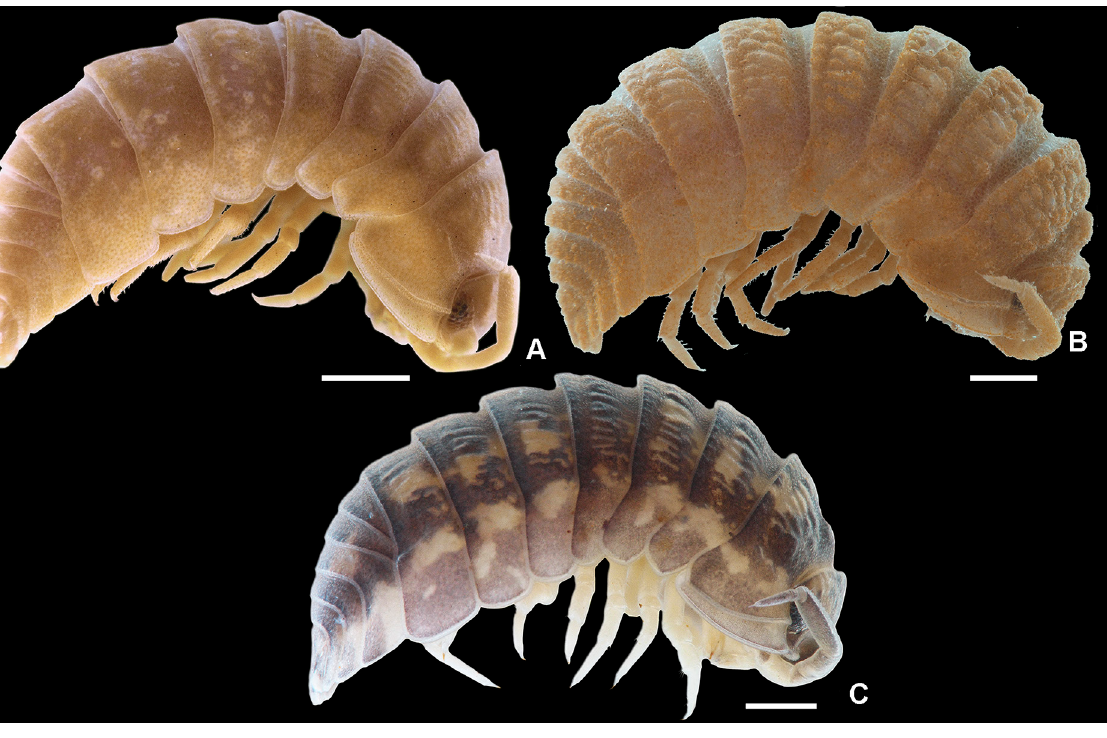
Fig. 7. A . Brasiloniscus maculatus (Lemos de Castro, 1973) gen. et comb. nov., paratype, ♂ (MNRJ 6212). – B . Brasiloniscus verrucosus (Lemos de Castro, 1973) gen. et comb. nov., paratype, ♀ (MNRJ 6214). – C . Brasiloniscus littoralis gen. et sp. nov., paratype, ♂ (MZUSP 36182). Scale bars: 1